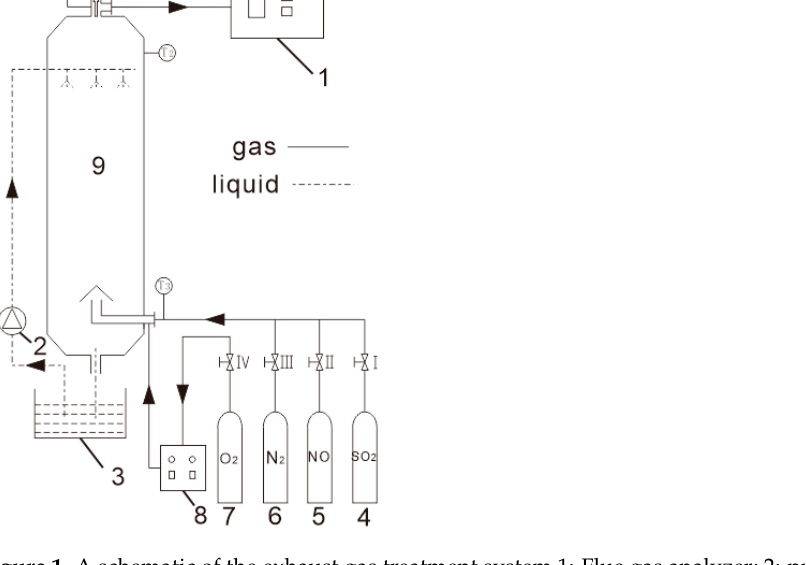
Figure 1. A schematic of the exhaust gas treatment system 1: Flue gas analyzer; 2: pump; 3: solution tank; 4–7: air bottle; 8: ozone generator; 9: reactor. T 1: Flue gas outlet temperature; T 2 : Scrubbing temperature; T 3 : Flue gas inlet temperature. I, II, III, IV: mass flow meters.